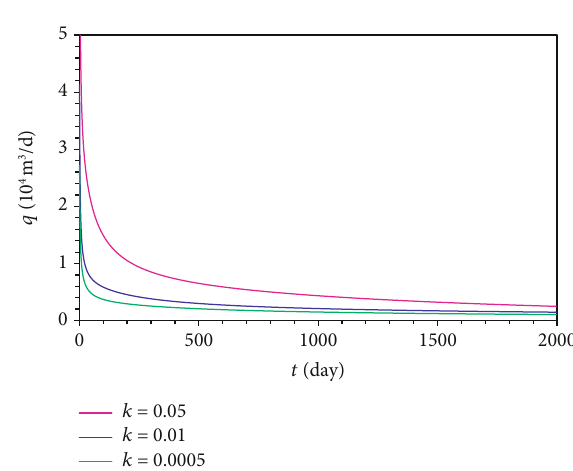
Figure 2: Rate vs. time with varied permeability.